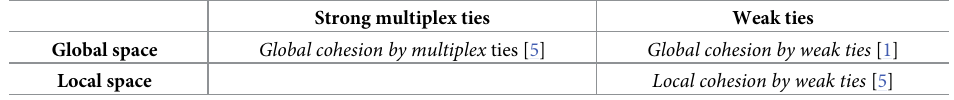
Table 1. Network data and hypothesis on social